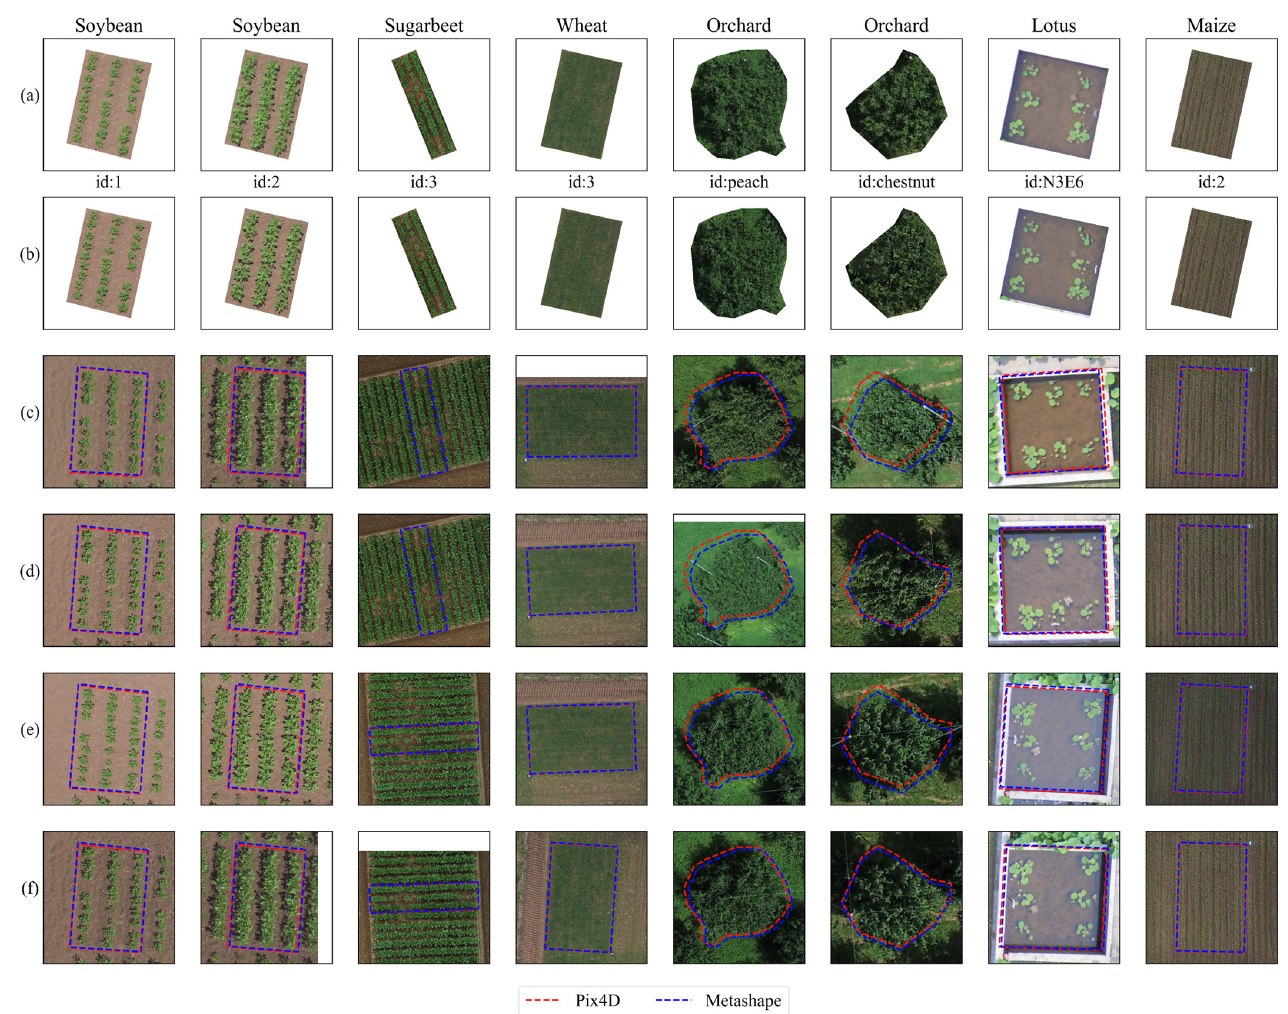
Figure 4. Reverse calculation results for six fields. Both Metashape and Pix4D results are used. ( a ) ROI from Pix4D-produced DOM and ( b ) ROI from MetaShape-produced DOM. ( c – f ) Randomly selected examples of ROIs on four raw UAV images. The Pix4D lines could be covered by the blue Metashape lines once no significant differences were observed.